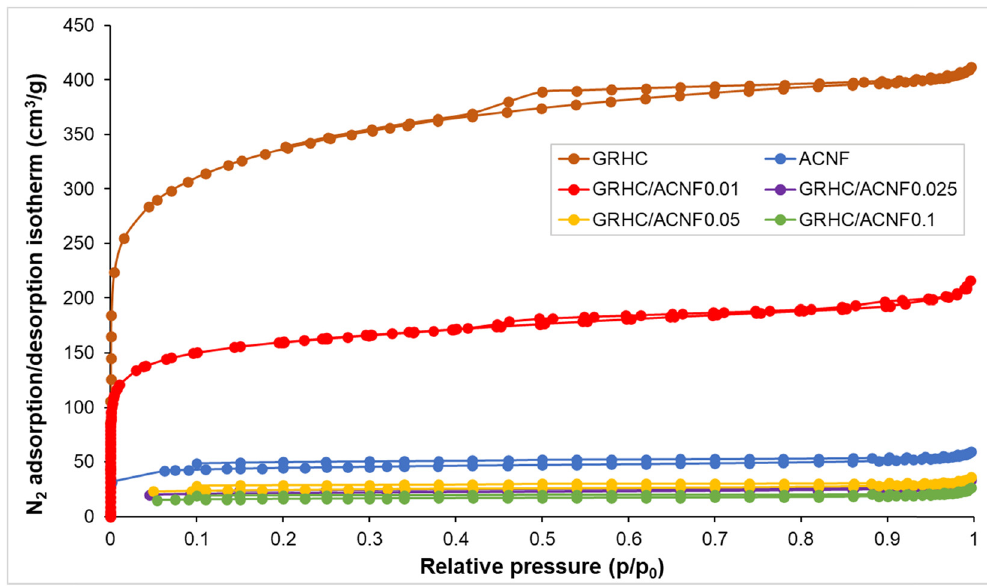
Figure 1: N 2 adsorption/desorption isotherms of ACNFs synthesized at di ff erent loadings of GRHC after